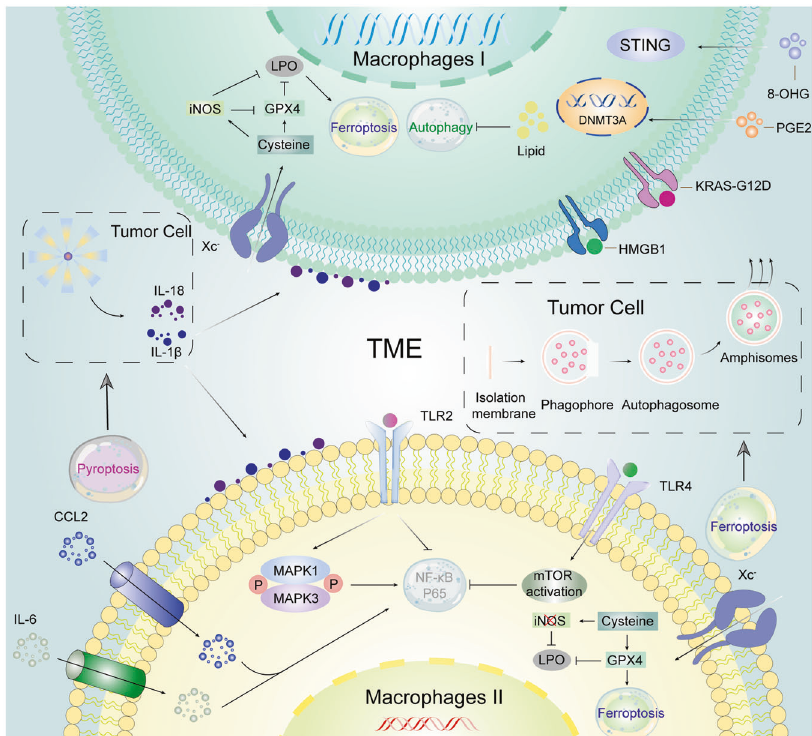
Fig. 3 Crosstalk between Macrophages I/II cells and dying cancer cells in the tumor microenvironment. Tumor cells affect the function of macrophages by releasing DAMPs such as KRAS-G12D, HMGB1, 8-OHG, and PGE2 through ferroptosis. Pancreatic cancer cells can release KRAS-G12D during ferroptosis, whose exocytosis is largely dependent on autophagosome-derived amphisomes. KRAS-G12D triggers M2 cells polarization by binding to AGER which might induce adaptive immunosuppression. In addition, iron-addicted cancer cells activate STING- dependent DNA sensor pathways in M1 cells through the release of 8-OHG to create an in fl ammatory microenvironment for tumor growth. Similarly, PGE2, induced by ferroptotic cancer cells can act on DNMT3A, causing DNA methylation thus suppressing immunogenic genes. M1 cells are more resistant to ferroptosis than M2 cells, even in the absence of GPX4. Mechanically, iNOS which is highly expressed in M1 cells but inhibited in M2 cells produces more NO (cid:129) , replacing GPX4 as a negative regulator of ferroptosis. Furthermore, excessive lipid accumulation in macrophages can prevent autophagy in obese mice, thus promoting the conversion of macrophages into pro-in fl ammatory M1 cells. In the TME, IL-6, and CCL2 trigger autophagy by binding to IL-6R and CCR2, respectively, which is essential for macrophage polarization to M2 phenotype. Furthermore, in M2 cells, TLR2 signaling inhibits the NF- κ B signaling pathway through selective autophagy. TLR2 signaling also promotes sustained phosphorylation of MAPK1 and MAPK3, which stimulates autophagy-dependent NF- κ B regulation. Autophagy can be inhibited in M2 cells regulated by TLR4-mTOR pathway. In addition, triggered by NLRP3 in fl ammasome, tumor cell-derived IL-1 β and IL-18 recruit M1/2 cells to inhibit or promote tumor